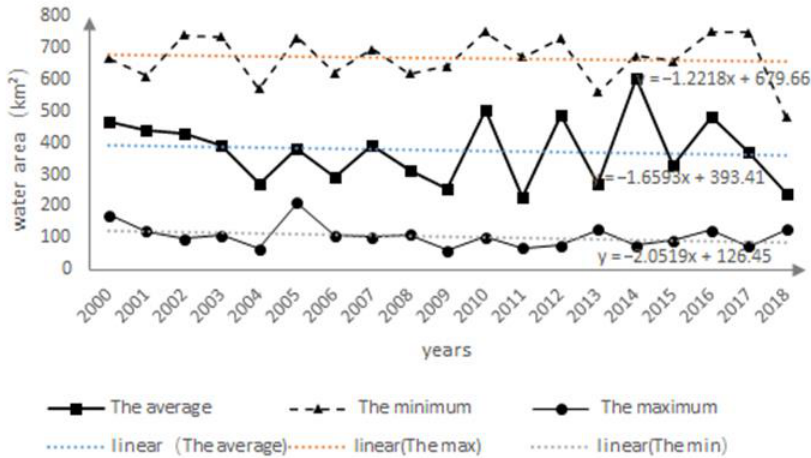
Figure 3. Interannual water area change curve of the seasonal lakes.